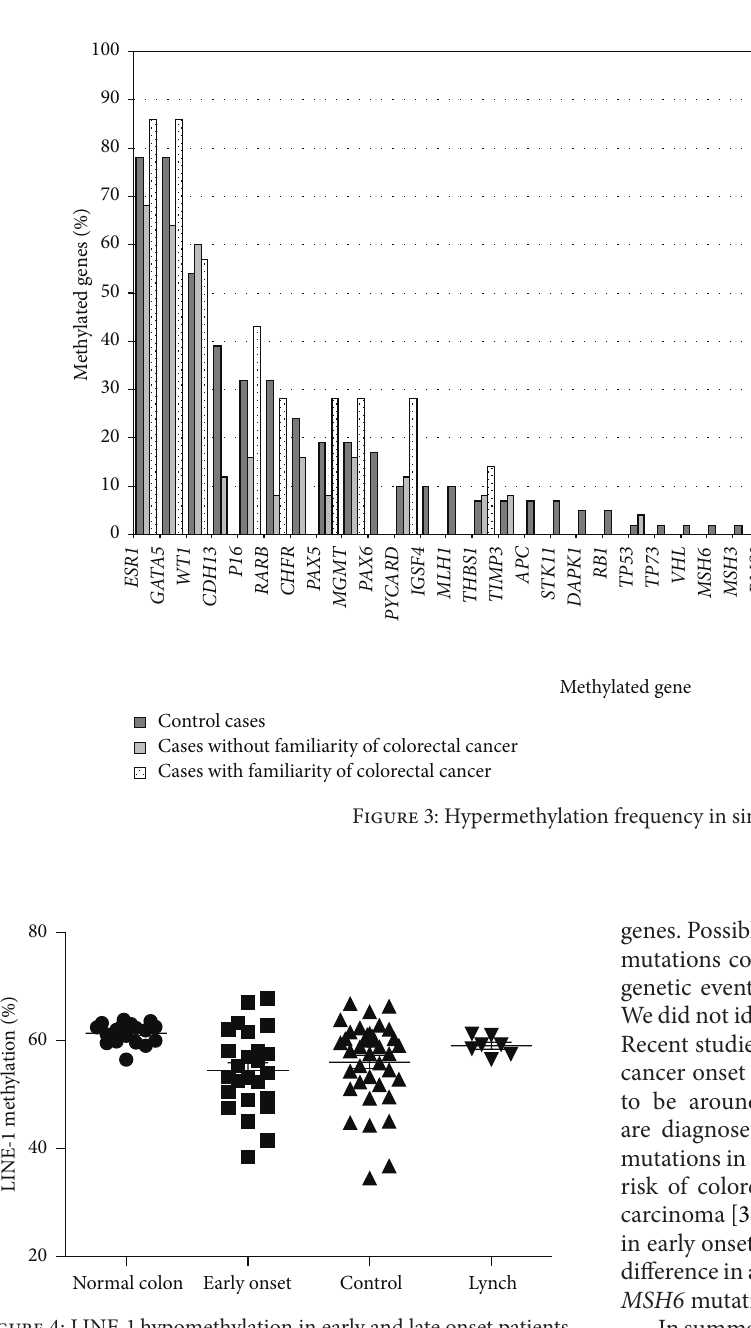
Figure 4: LINE-1 hypomethylation in early and late onset